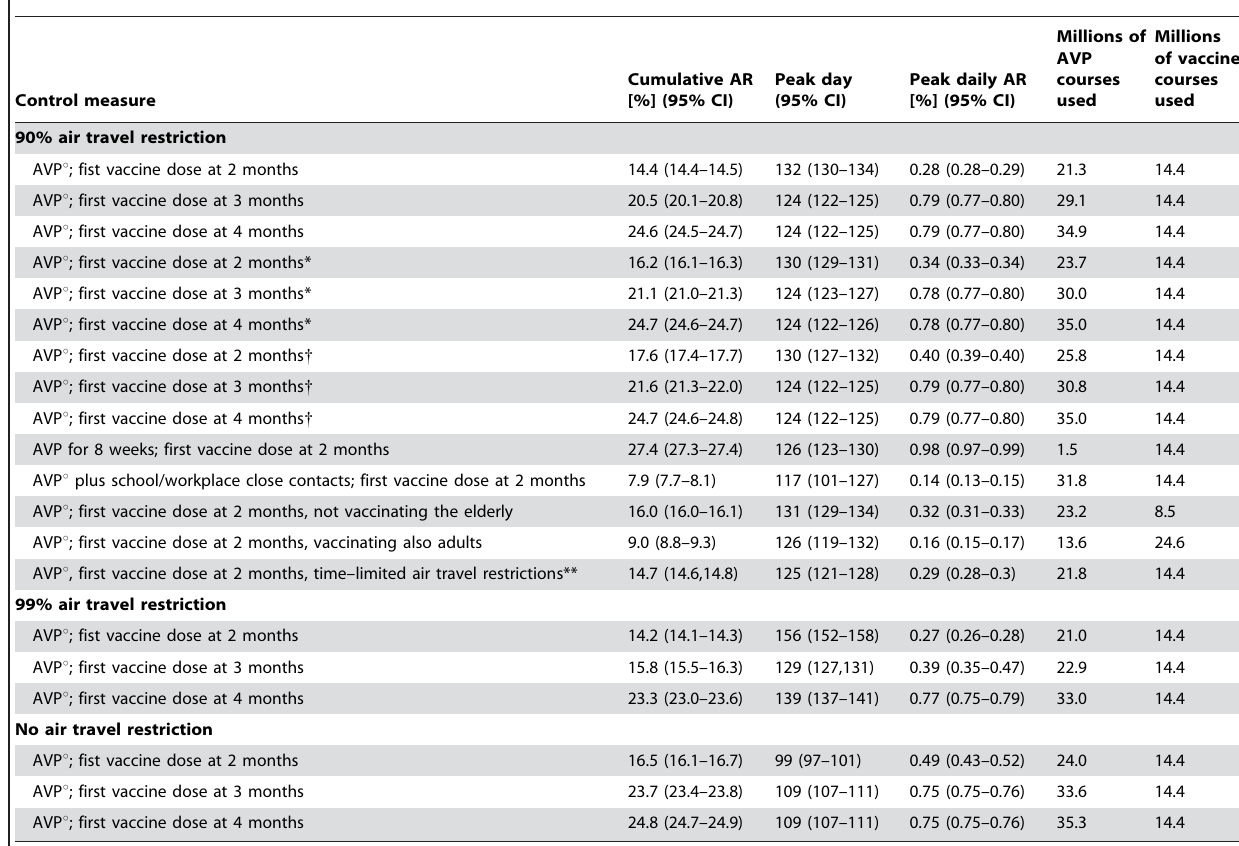
Table 6. Clinical attack rates and peak day, by combination of control